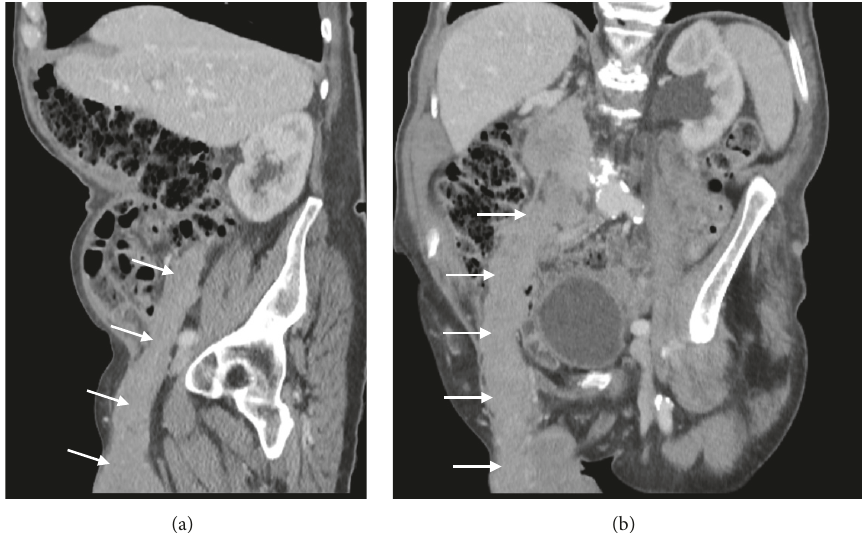
Figure 6: (a and b) Sagittal and coronal reformatted CT images of the abdomen and pelvis with contrast demonstrating cranial extension of the tumour from the scrotum, along the spermatic cord in the inguinal canal and into the retroperitoneum along the right gonadal vein, to the level of its insertion into the inferior vena cava. Incidental note made of a left extrarenal pelvis.